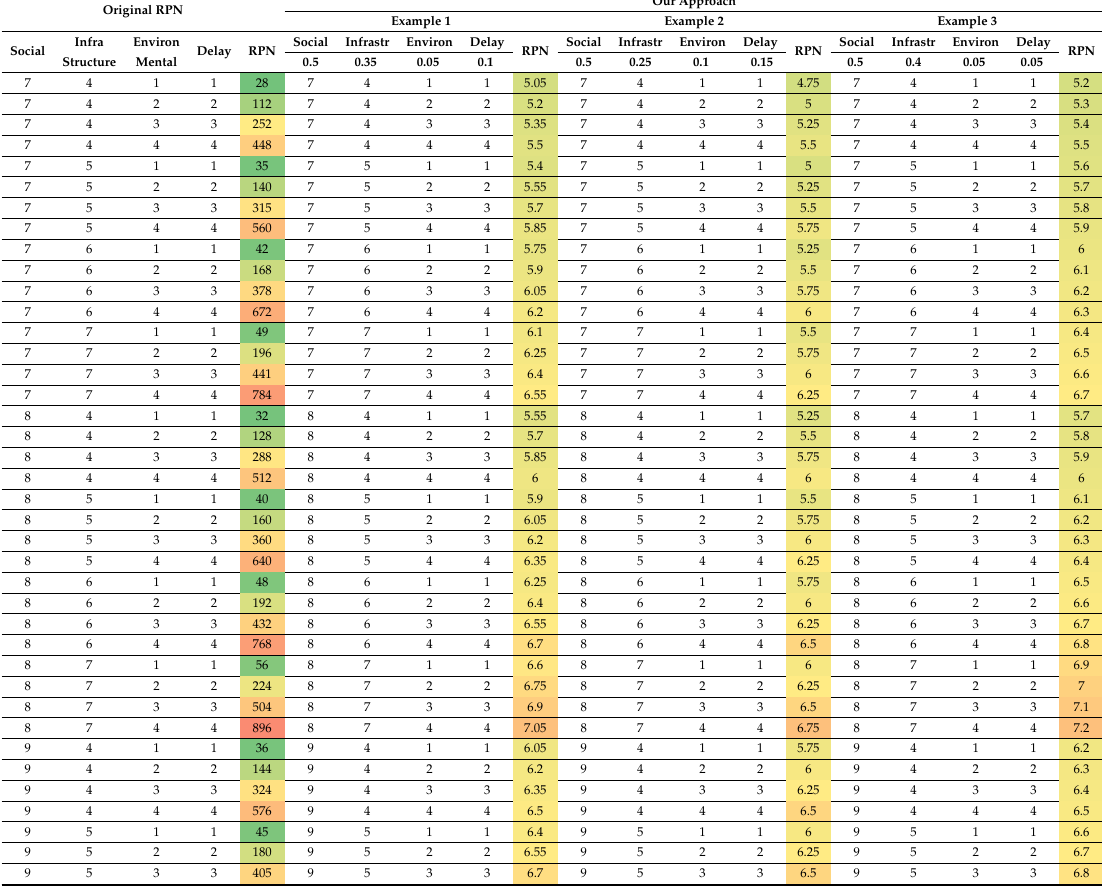
Table 7. Example of some results obtained when testing the weight